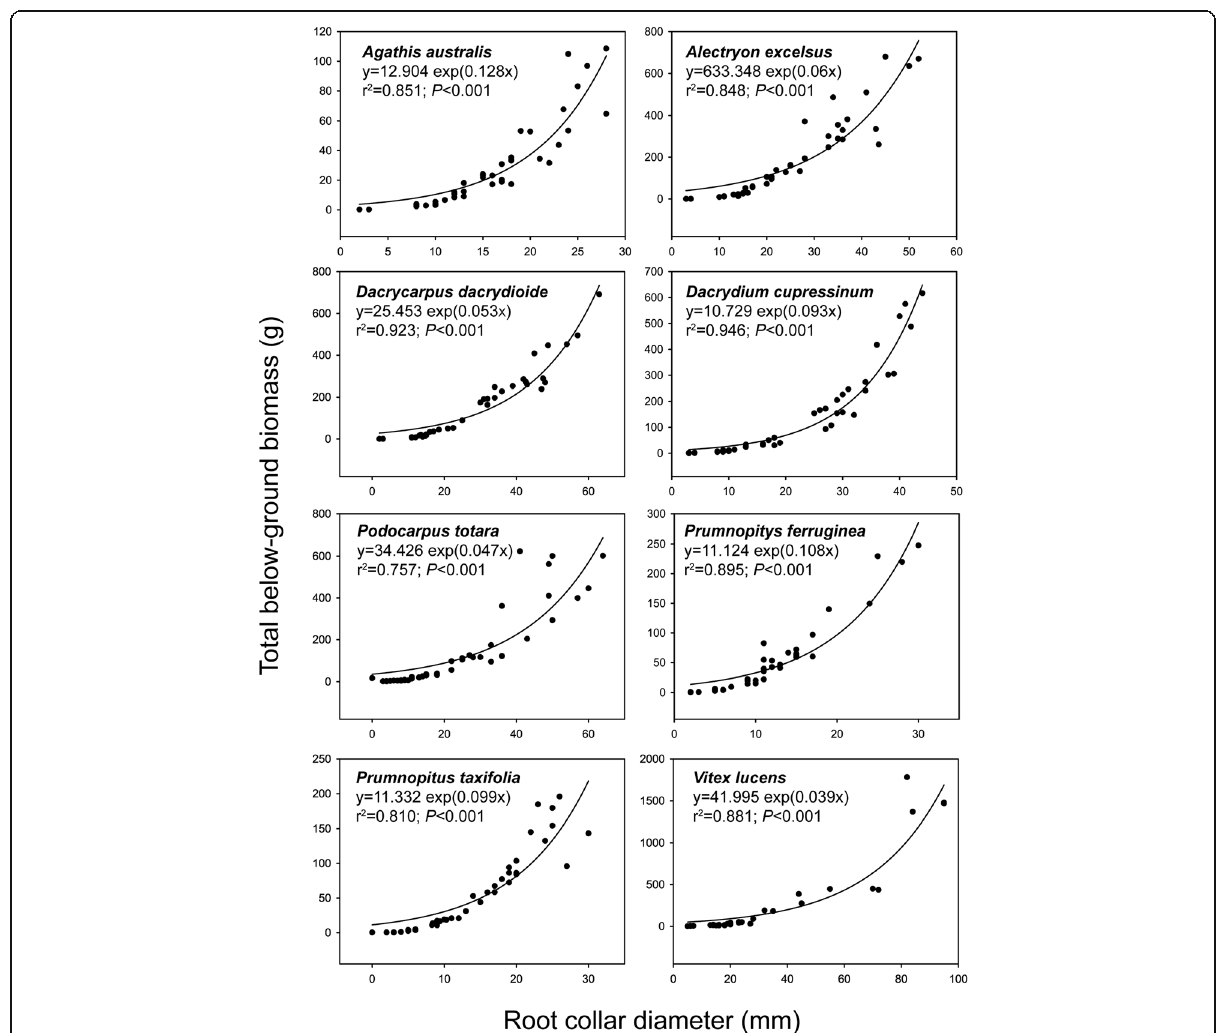
Fig. 6 Exponential growth analysis of RCD and total below-ground biomass. Note that the scale of the y and x axes differs between